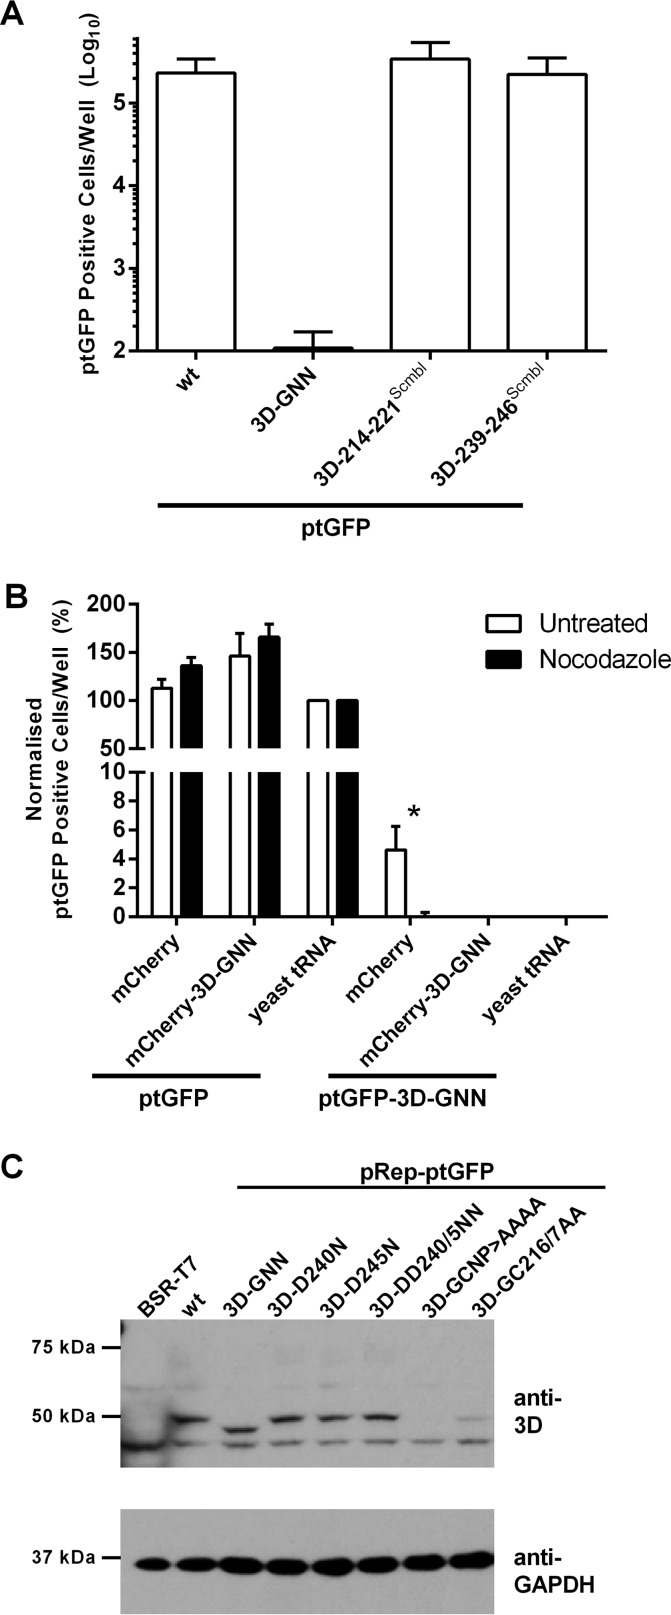
Replication-defective 3D mutations do not affect RNA structure or 3D polyprotein processing. (A) Replicon RNAs containing codon-modified 3D were transfected into BHK-21 cells along with control replicons, and ptGFP expression was monitored hourly over 24 h. Data show mean numbers ± SD of ptGFP-positive cells per well at 8 h posttransfection (n = 2). (B) Effect of nocodazole on complementation. BHK-21 cells treated with 5 μM nocodazole or left untreated (see Materials and Methods for details) were cotransfected with wild-type or 3D-GNN ptGFP replicon RNA together with helper mCherry replicon or yeast tRNA negative control. ptGFP expression was monitored for 24 h. Data show normalized numbers of ptGFP-positive cells per well ± standard errors of the means (SEM) at 8 h posttransfection. Significance between results for untreated samples and samples treated with 5 μM nocodazole (n = 3) was determined: *, P < 0.05. (C) Western blot analysis of replicon DNA constructs transfected into BSR-T7 cells. Cells were seeded into 12-well plates, allowed to adhere for 16 h, and transfected with ptGFP replicon DNA constructs as indicated, and protein was harvested at 12 h posttransfection. Lysates were analyzed by Western blotting for 3D and GAPDH (glyceraldehyde-3-phosphate dehydrogenase) expression.